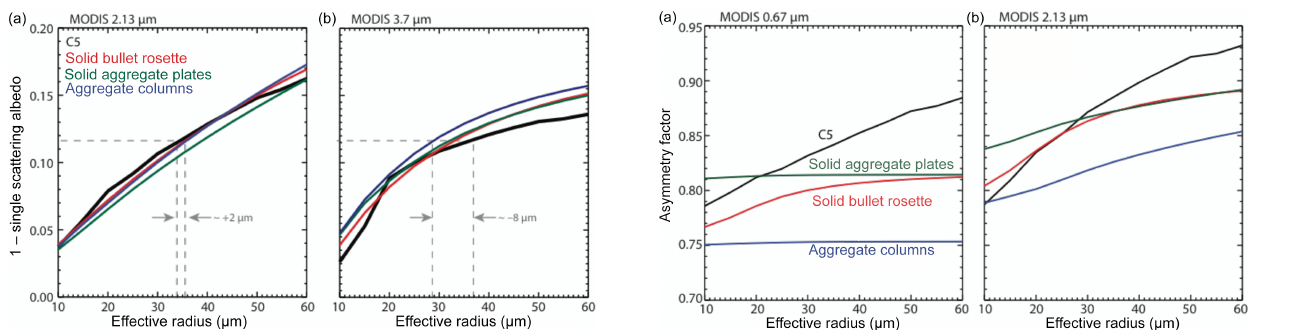
Figure 6. The relationship between effective radius and single- scatter asymmetry parameter in the MODIS (a) 0.67 and (b) 2.13µm channels for different ice particle radiative models. Note the strong dependence of the MODIS C5 model asymmetry parameter on effective size. The other models consist of a single habit with severely roughened surfaces. The single-habit calcula- tions are made for a modified gamma size distribution and an effec- tive variance of